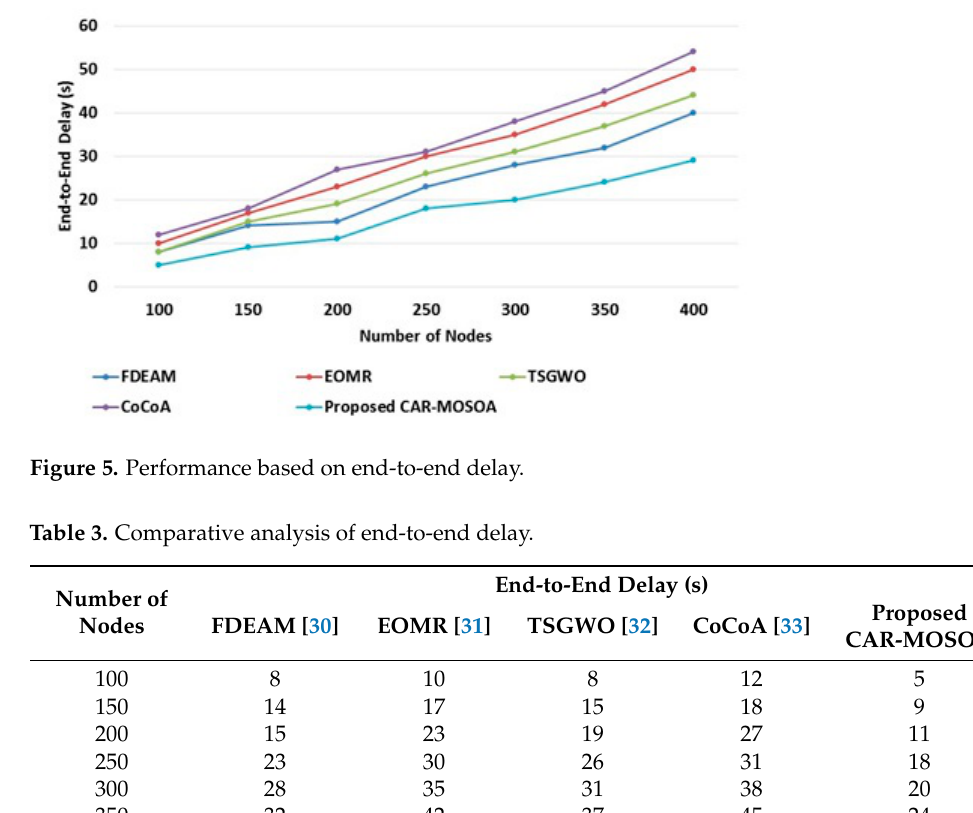
Table 4. Comparative analysis of packet delivery ratio.